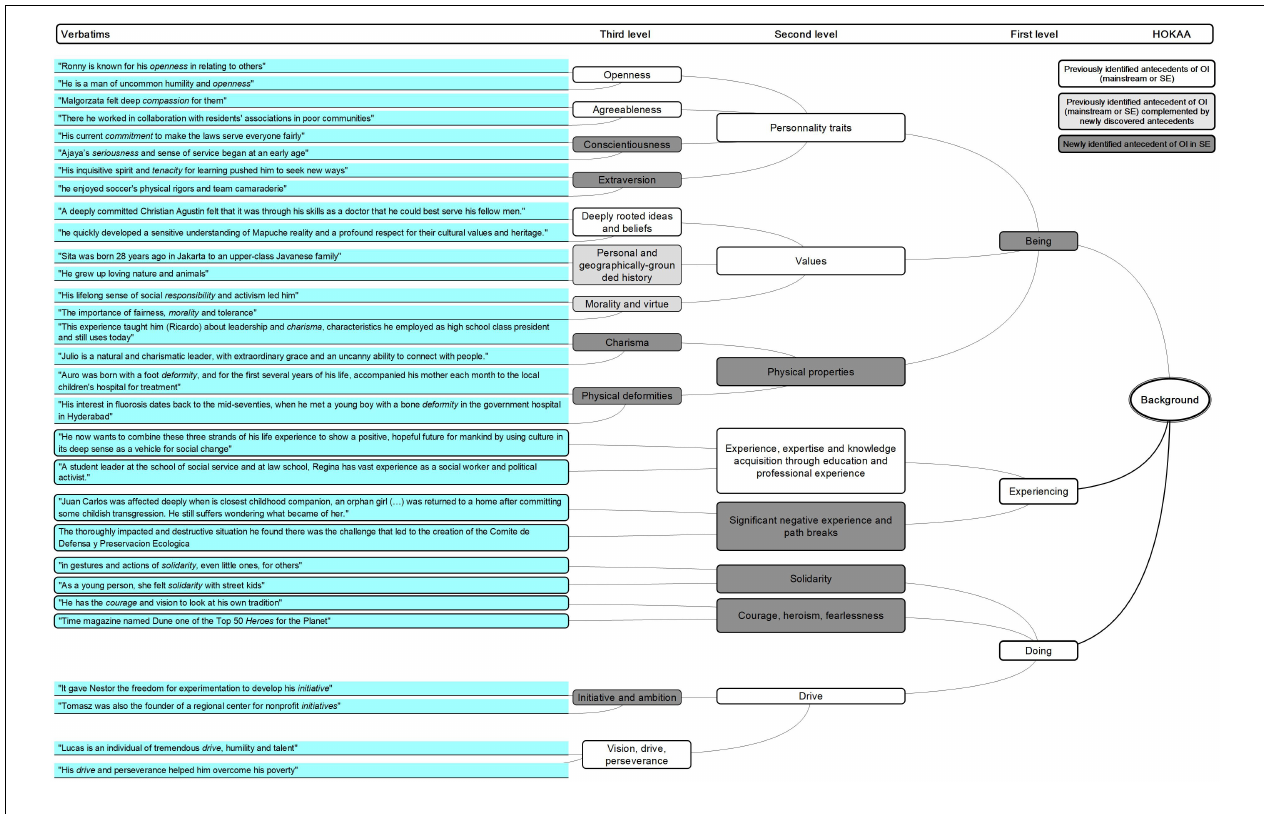
FIGURE 3 | HOKAA ‘Background’: emerging antecedents.